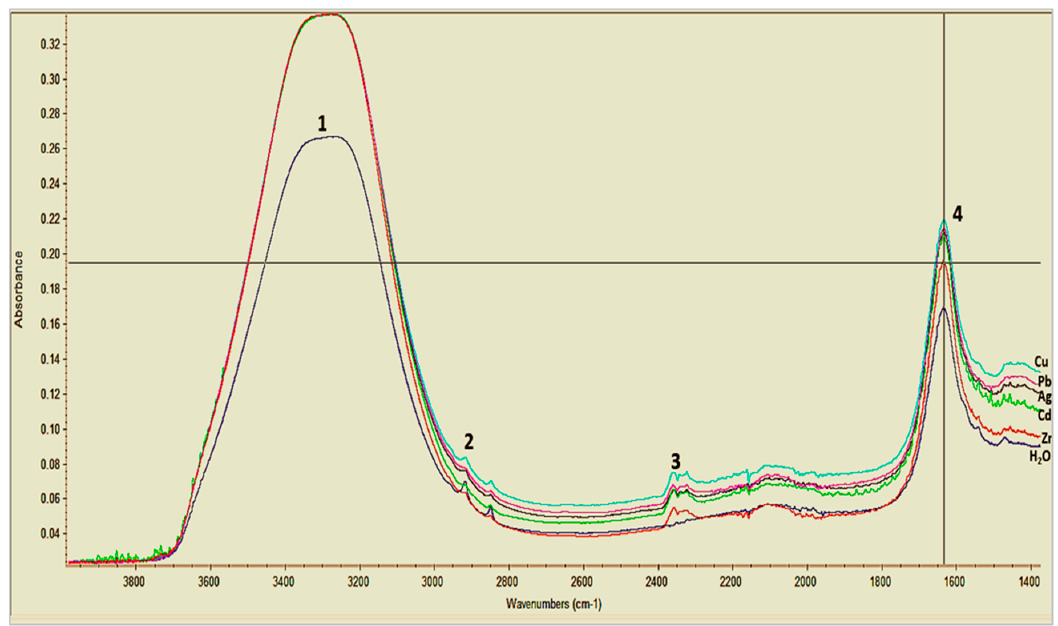
Figure 1. Showing the Fourier Transform Infrared ( FT-IR) spectra metal ions in the standards and the water samples.